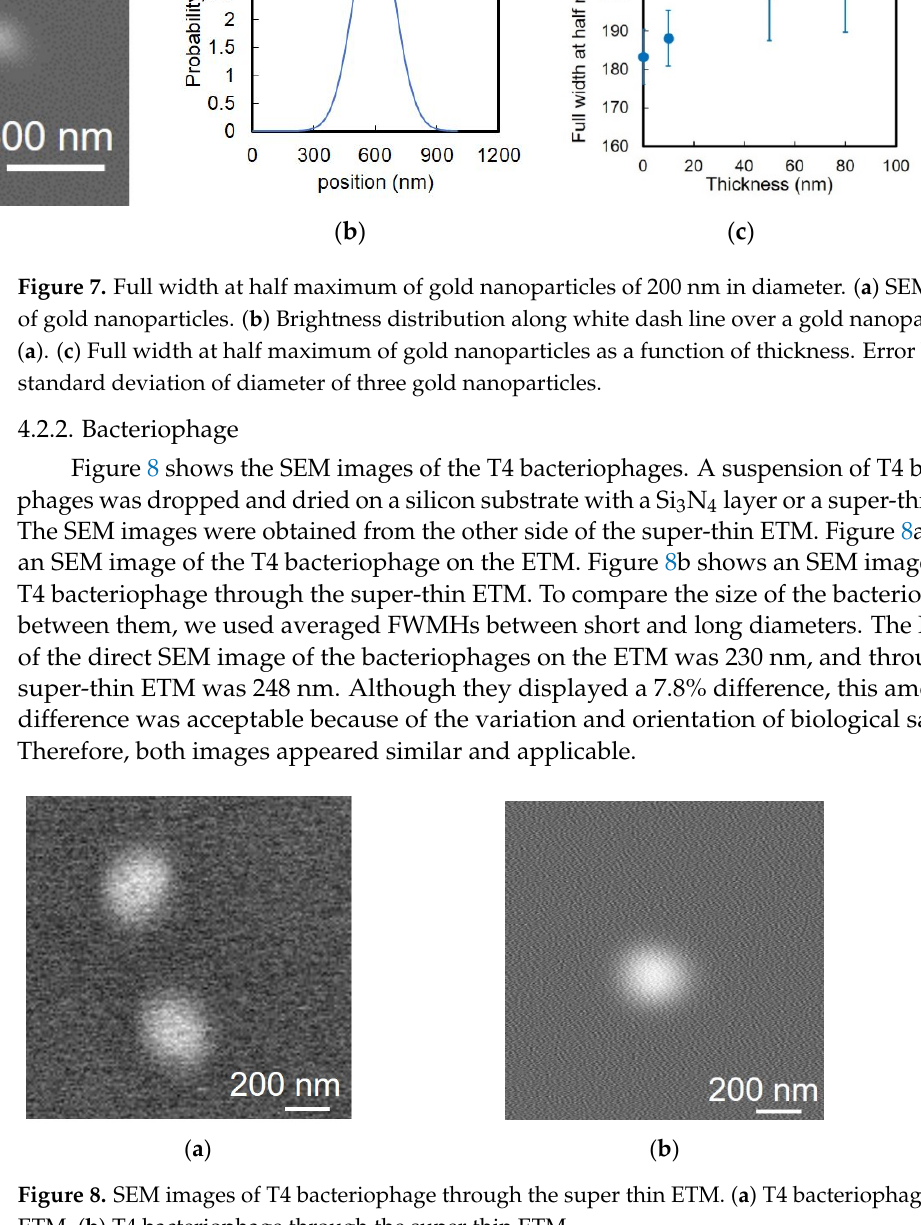
( d ) Figure 9. Images of cyanobacteria in liquid using the microfluidic liquid cell with the super-thin ETM. ( a ) Bright-field optical microscope image of cyanobacteria in liquid. ( b ) SEM image of bacte- rium in liquid through an 80-nm-thick ETM. ( c ) SEM image of bacterium in liquid through a super- thin ETM. It has microstructures (white arrows). ( d ) Outline of bacterium in processed SEM image. 5. Conclusions This study developed a microfluidic liquid cell with a thin ETM. The super-thin ETM was fabricated via anisotropic wet etching of silicon bonded to a PDMS microchannel. The PDMS microchannel prevented etching of the super-thin ETM. Through the super-thin